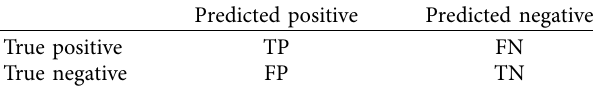
Table 5: Confusion